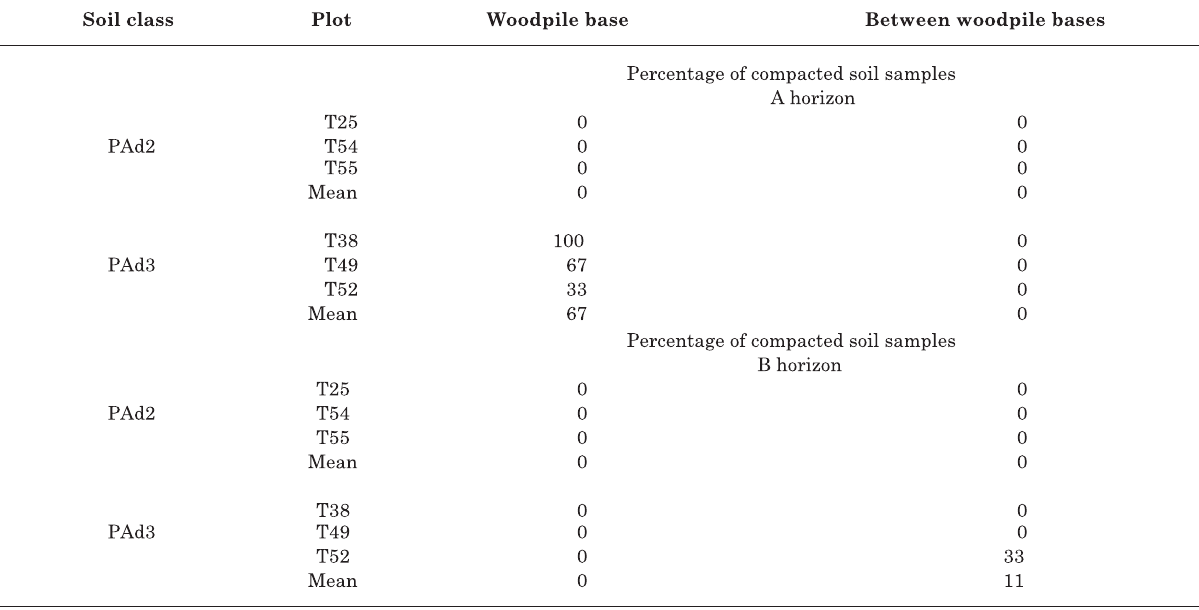
Table 5. Classification of the soil samples according to figure 1, using the preconsolidation pressures values determined in the wood bases and between the wood